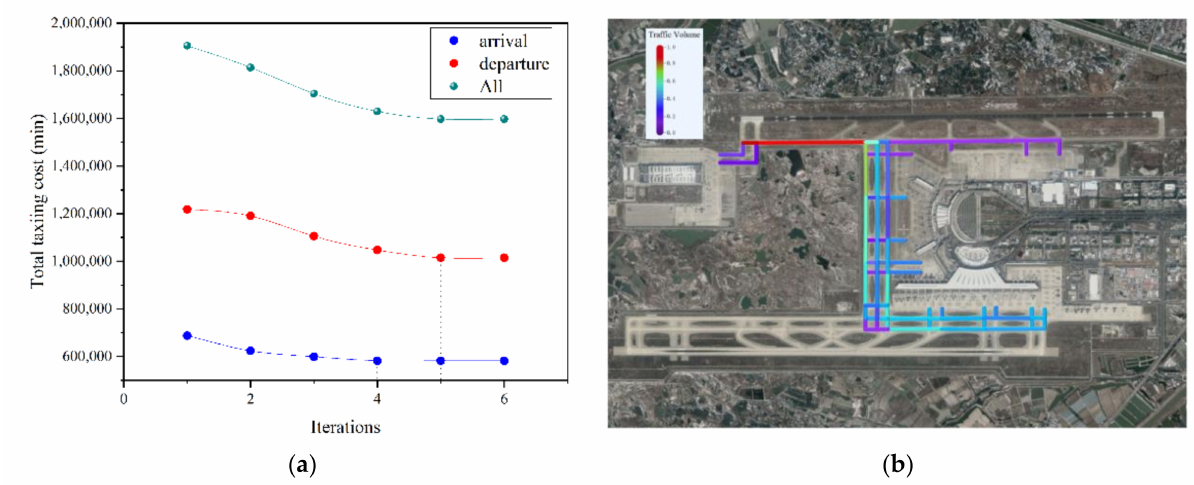
Figure 10. The result of SOTA. ( a ) The convergence process of iteration; ( b ) the optimized flow distribution in taxiway network based on